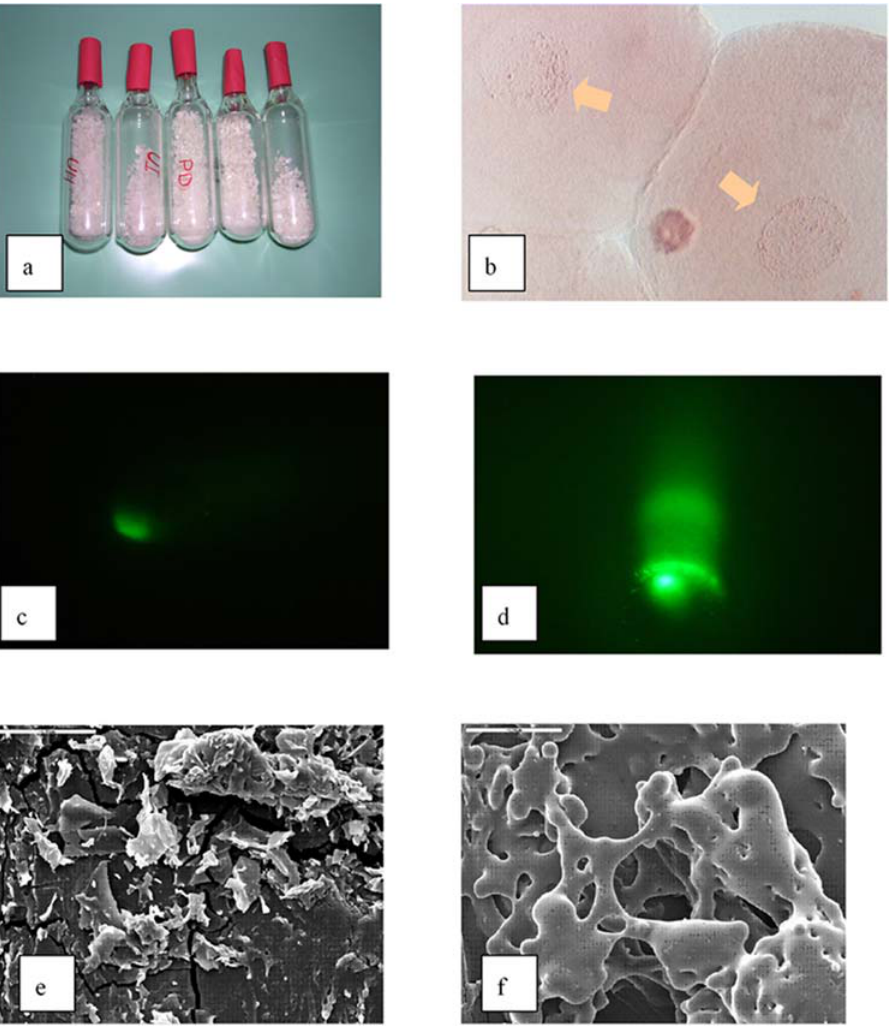
Figure 1. a, ampules with freeze-dried sheep granulosa cells. b, irregular pronuclei with fragmented DNA (10 hours after activation), aceto- orcein staining. 6 400. c, d, comet analysis in pronuclear stage embryo reconstructed with a control (fresh) granulosa cell (c), and with a freeze–dried cell (d). 6 40. e, f, SEM appearance of the lyophilized cells without (e) and with (f) trehalose. 6 350